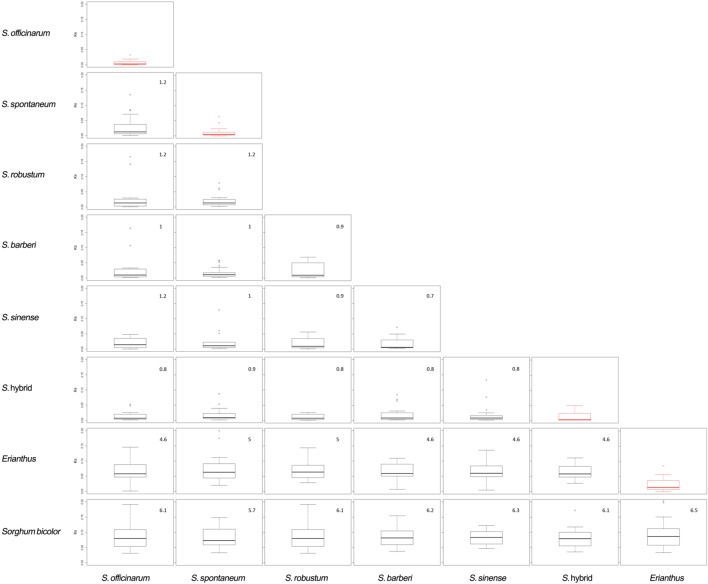
Divergence plots between different accessions. The red boxplot shows the Ks between two accessions from same species.